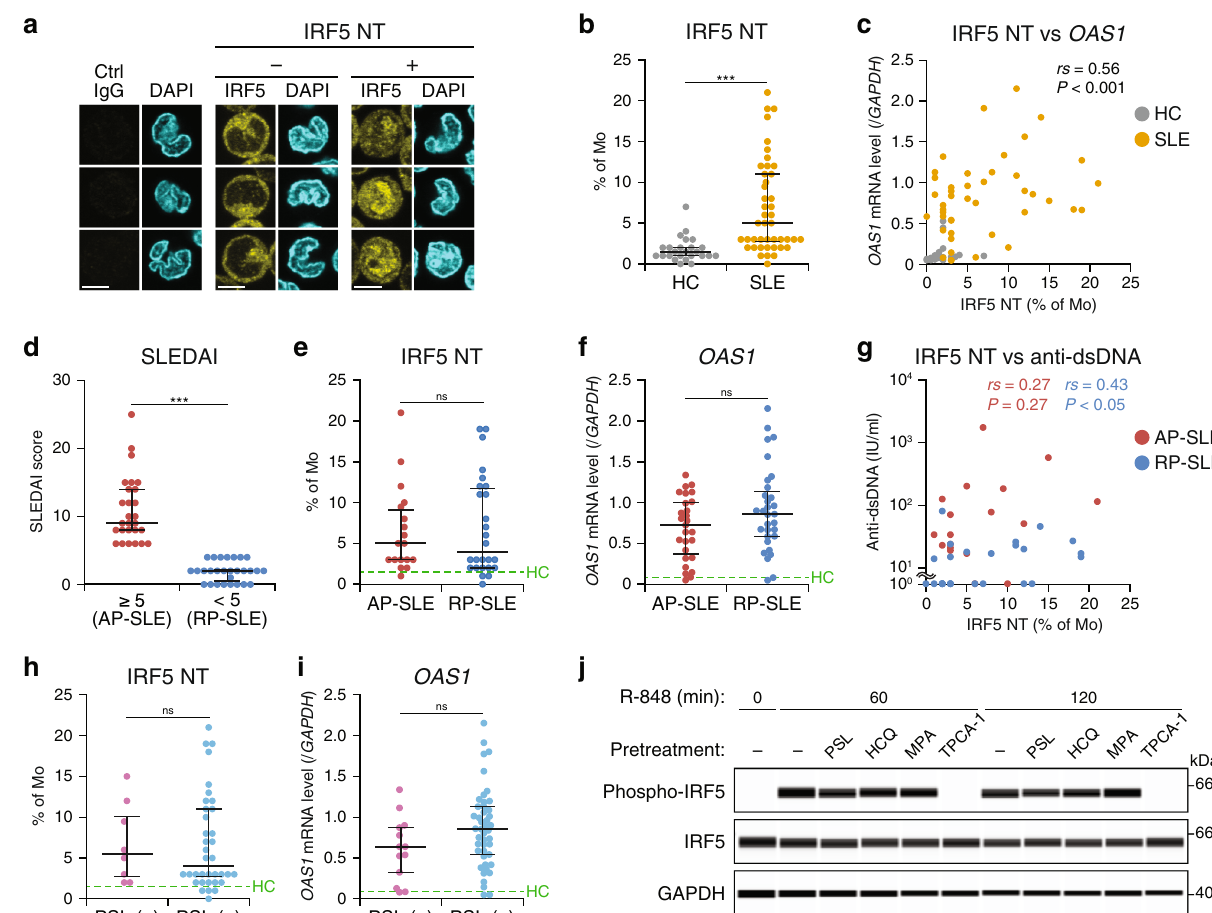
Fig. 1 Activation status of IRF5 in human SLE. a Evaluation of IRF5 activation by nuclear translocation (NT). Fluorescent images of monocytes (Mo), stained with control IgG (left) or an anti-IRF5 antibody (middle and right) and then with a fl uorochrome-conjugated secondary antibody (yellow), were captured by confocal microscopy. Nuclei were stained with DAPI (cyan). Representative images of cells with or without IRF5 NT, obtained from two of the SLE patients and one of the healthy control (HC) donors, respectively, analyzed in b are shown. Scale bars represent 5 μ m. b IRF5 hyperactivation in SLE- associated monocytes. The IRF5 NT was de fi ned as the nuclear/cytosolic IRF5 ratio of >1.5× most frequent ratio from the same sample containing 75 – 100 cells (see “ Methods ” ). The proportion of monocytes featuring IRF5 NT in HC donors and SLE patients. c Correlation between IRF5 NT and ISG expression. A scatterplot of IRF5 NT prevalence among monocytes and the OAS1 mRNA level in peripheral blood are shown. d – f Persistence of aberrant IRF5 activation and ISG expression in remission-phase (RP)-SLE. Active-phase (AP)- and RP-SLE were de fi ned as the SLEDAI-2K ≥ 5 and <5, respectively ( d ). The percentage of monocytes with IRF5 NT ( e ) and the OAS1 mRNA level in peripheral blood ( f ) in AP- and RP-SLE were analyzed. g Correlation between IRF5 NT and the anti-dsDNA antibody level in RP-SLE. A scatterplot of IRF5 NT prevalence among monocytes and serum anti-dsDNA antibody concentration in AP- and RP-SLE are presented. h , i Persistence of aberrant IRF5 activation and ISG expression after the standard therapy. Percentages of monocytes featuring IRF5 NT ( h ) and OAS1 mRNA levels in peripheral blood ( i ) from SLE patients treated or not treated with PSL were analyzed. j Effects of standard- of-care drugs on IRF5 activation. PBMCs from a HC donor were pretreated with 1.5 μ M PSL, 3 μ M HCQ, 60 μ M mycophenolic acid (MPA), or 1 μ M TPCA-1 (positive control) for 30 min and then stimulated with 3 μ M R-848 for 60 or 120 min. The cell lysates were analyzed by a capillary-based immunoassay with antibodies against phosphorylated IRF5 (phospho-IRF5), total IRF5, and GAPDH as a loading control. Representative data from two independent experiments are depicted. HC: n = 25, SLE: n = 44 ( b , c ), AP-SLE: n = 27 ( d , f ), or 18 ( e , g ), RP-SLE: n = 31 ( d , f ) or 26 ( e , g ), PSL ( − ): n = 8 ( h ) or 13 ( i ), PSL ( + ): n = 36 ( h ) or 45 ( i ). Horizontal bars ( b , d – f , h , i ) represent median with interquartile range. Dashed lines ( e , f , h , i ) indicate the median of HC data. *** P < 0.001, ns: not signi fi cant (two-sided Mann – Whitney U test). Two-sided Spearman ’ s rank correlation coef fi cients ( r s) and P value were used to assess the correlation ( c , g ). factor κ -B (NF- κ B) kinase subunit β (IKK β ; the kinase that activates NF- κ B and IRF5) 21,22 served as a positive control. TPCA-1 inhibited nuclear translocation of both IRF5 and NF- κ B p65 in monocytes and pDCs as expected (Supplementary Fig. 4b, c), indicating that IKK β inhibitors are not suitable for IRF5- speci fi c suppression.